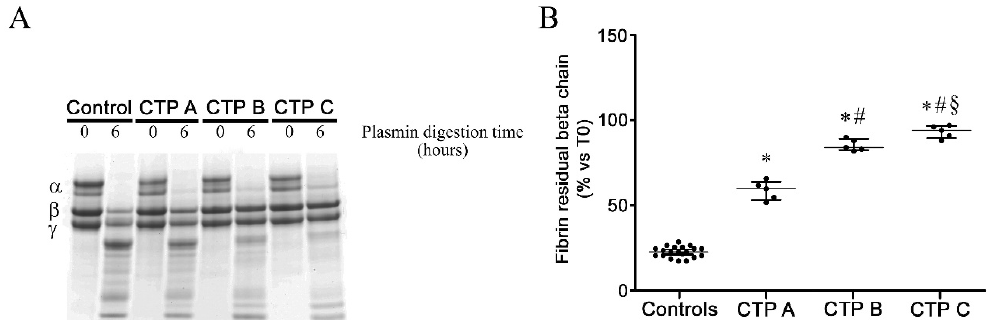
Figure 2. Fibrin resistance to plasmin-induced lysis experiments. ( A ) Representative gel of fibrin degradation after 0, and 6 h of plasmin digestion using fibrinogen purified from patients with liver cirrhosis at di ff erent disease severity ( n = 5 for each Child–Turcotte–Pugh category) and controls ( n = 20). ( B ) Residual fibrin β chain intensity after 6 h of plasmin digestion in fibrinogen purified from patients with liver cirrhosis at di ff erent stages ( n = 5) and controls ( n = 20). All experiments were performed in triplicate. Values are represented as median with interquartile range. * Significant di ff erence vs. controls at the p < 0.05 level. # Significant di ff erence vs. CTP A at the p < 0.05 level. § Significant di ff erence vs. CTP B at the p < 0.05 level.